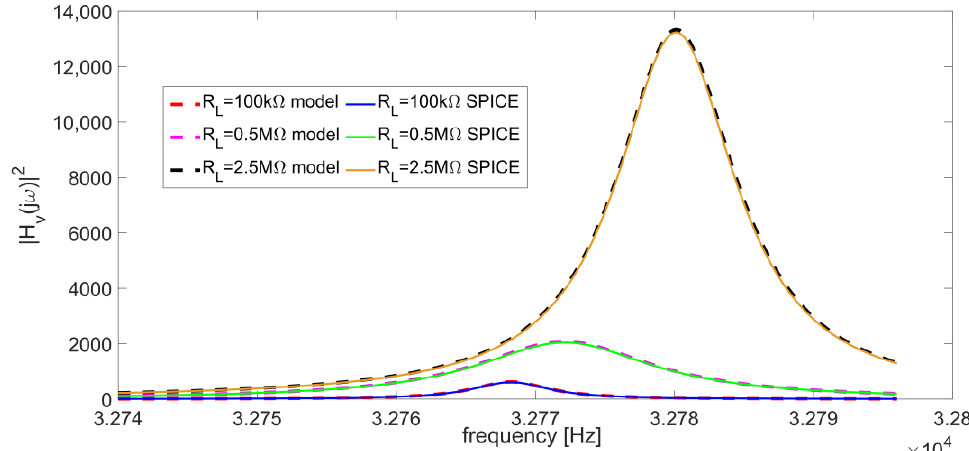
Figure 4. Comparison between SPICE simulations and analytical model in Equation (2) of the frequency response of the circuit in Figure 3 for R L = 100 k Ω , 0.5 M Ω and 2.5 M Ω .